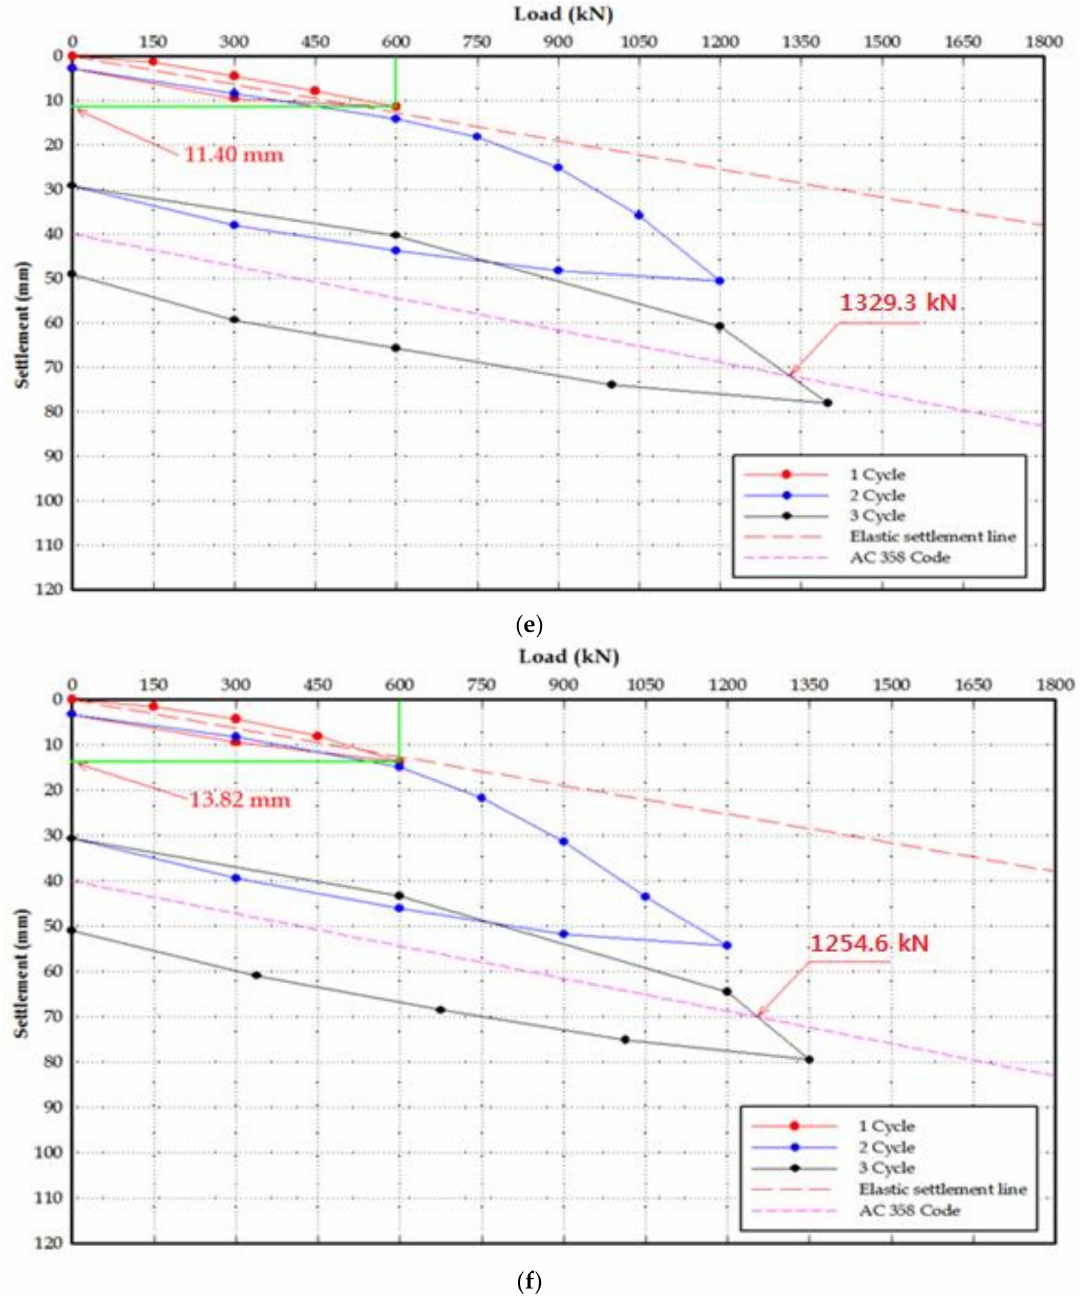
Figure 7. Static load test result for each site: ( a ) Site–1 #7; ( b ) Site–1 #8; ( c ) Site–1 #9; ( d ) Site–2 #7; ( e ) Site–2 #8; ( f ) Site–2